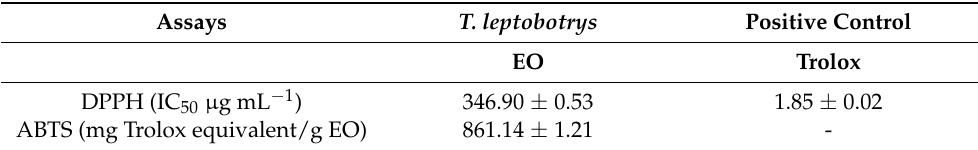
Table 3. Antioxidant activity of the essential oil of Thymus leptobotrys Murb.